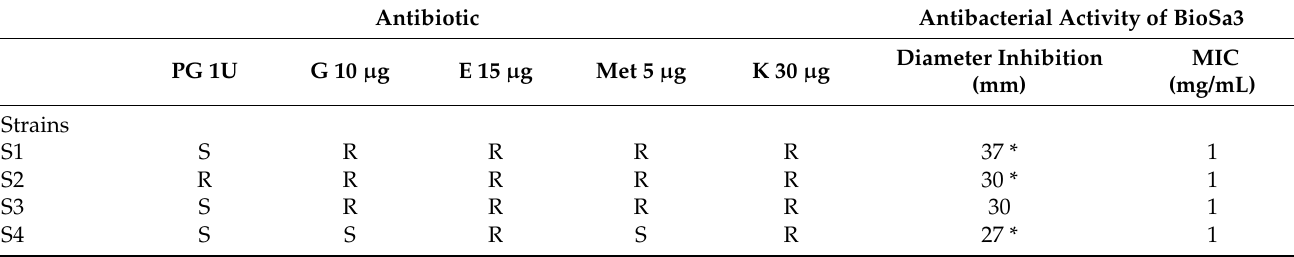
Table 2. Antibiotic resistance assay and antibacterial activity of BioSa3.